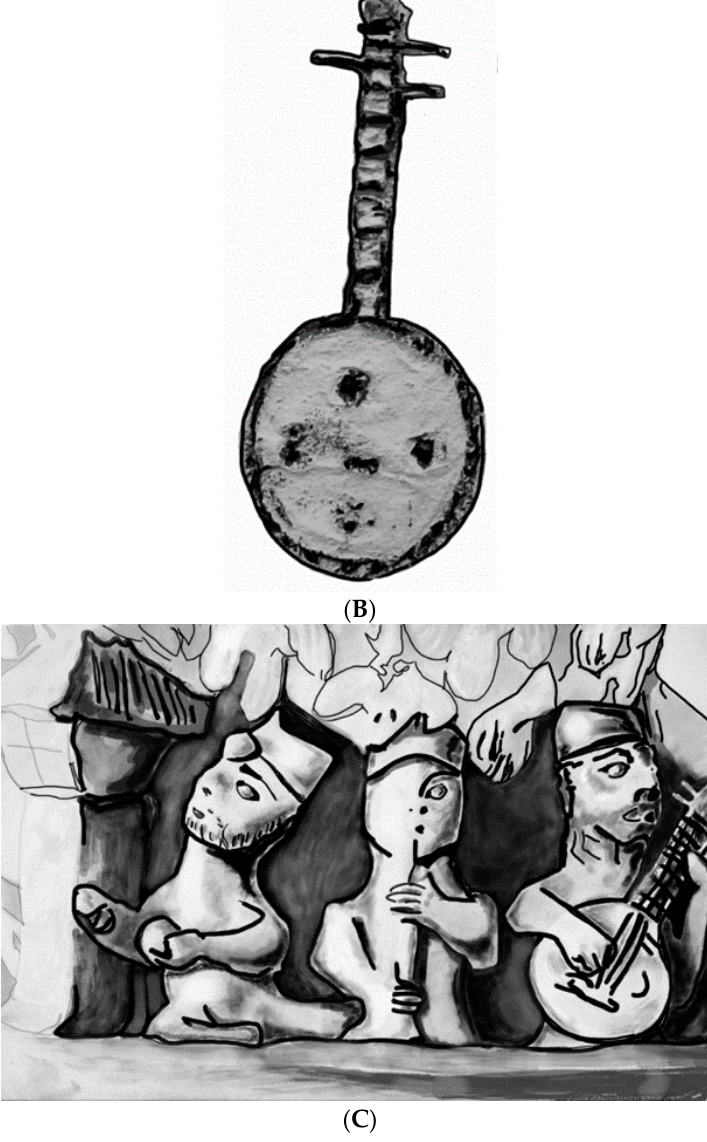
Figure 16. ( A ) Part of a mural painting from a tomb discovered from Xishanqiao 西善橋 , Nanjing 南京 , depicting Ruanxian playing the Qin Pipa—Ruanxian Qin. The early period of the South Dynasty 南朝 (439–589 CE). Sketched by author. Picture source: Zhang and Zhongguo Yinyue Wenwu Dxi Editorial Committee (1996a). ( B ) Part of a relief of a Qin Pipa from a tomb discovered in Huangguan Shan 皇冠山 , Fujian 福建 , chamber number: 19. 378–512 CE. Sketched by author. Picture source: Zhang and Zhongguo Yinyue Wenwu Dxi Editorial Committee (1996b). ( C ) Detail from an urn decorated with musicians holding a Qin Pipa discovered in Ruian 瑞安 , Zhejiang 浙江 . The Wu State 吳國 of the period of the Three Kingdoms 三國 (220–280 CE). Sketched by author. Picture source: Yu (1992).